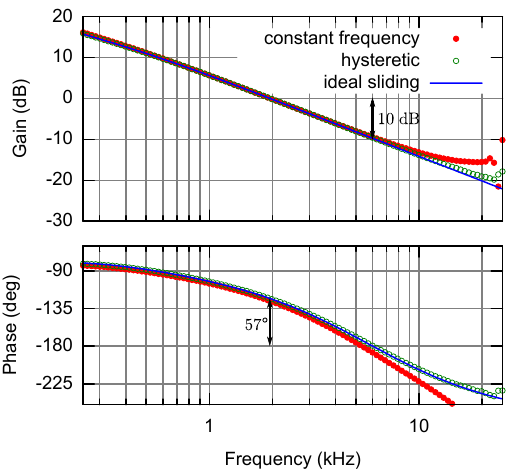
Figure 6. Theoretical and simulated loop gain Bode plots in a boost